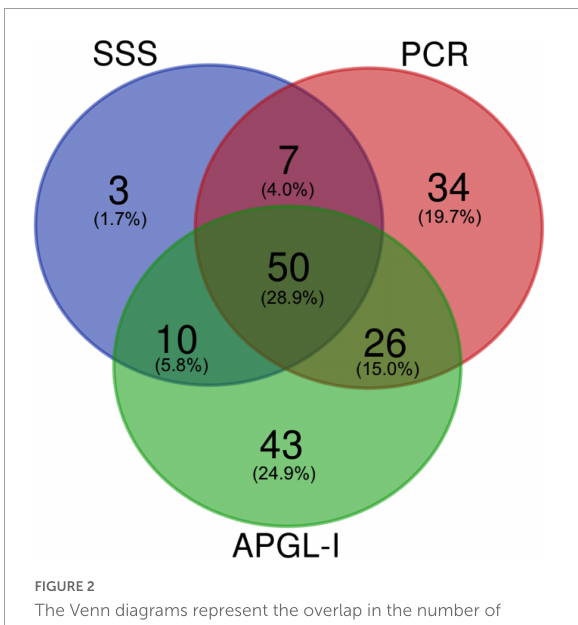
FIGURE2 The Venn diagrams represent the overlap in the number of positive SSS, PCR, and APGL-I index examinations in HD patients. Data were represented in absolute value and percentage relative to the total of positive tests ( n = 173/286). SSS, slit-skin smear; PCR, polymerase chain reaction; APGL-I, IgM anti-phenolic